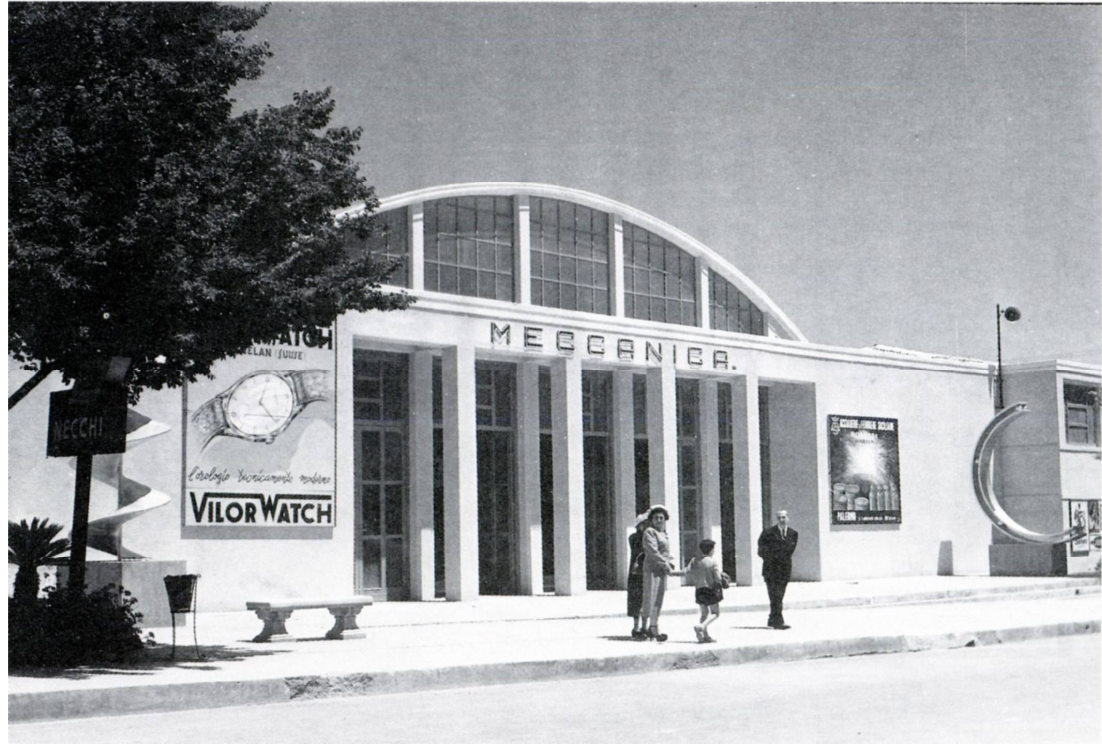
Figure 3. Mechanics Pavilion, Arch. Cardella,